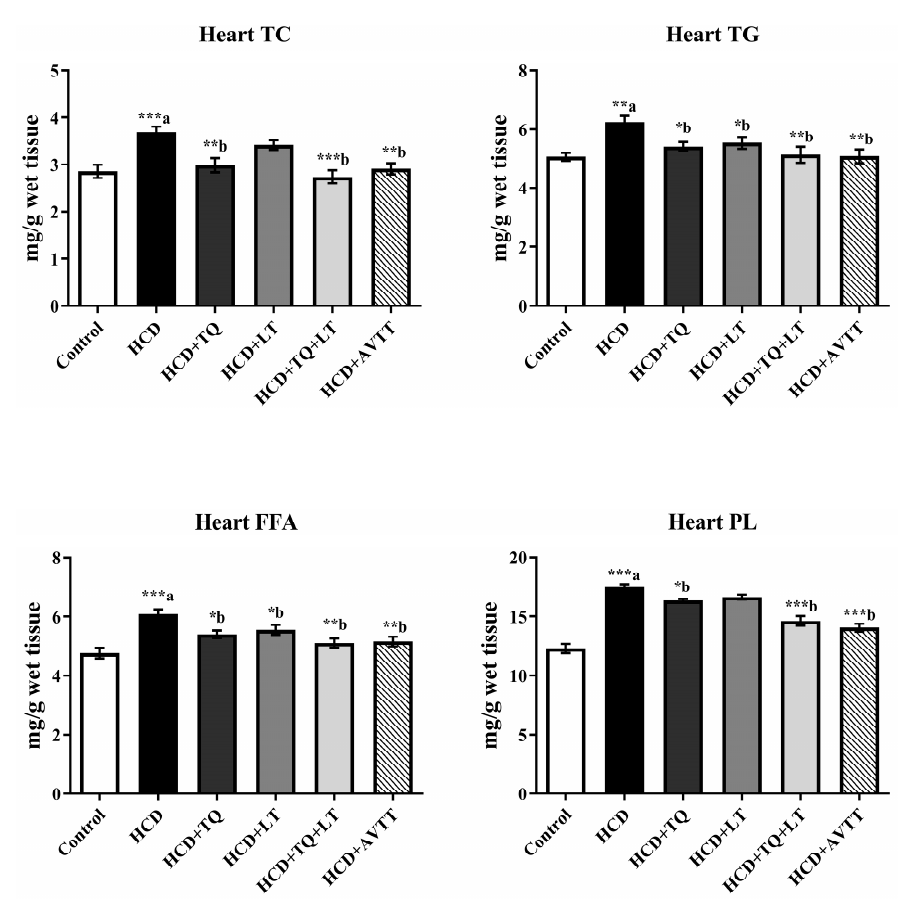
Figure 4. Effect of thymoquinone (TQ), losartan (LT) and their combination on high cholesterol diet (HCD)-induced changes in cardiac levels of total cholesterol (TC), triglyceride (TG), free fatty acids (FFA) and phospholipids(PL). Data are expressed as Mean ± SE (n = 6) and analyzed using one-way ANOVA followed by Student–Newman–Keuls as post hoc test. a Control vs. HCD group; b HCD vs. QT or LT or QT + LT. p values considered significant when * p < 0.05, ** p < 0.01 and *** p < 0.001.